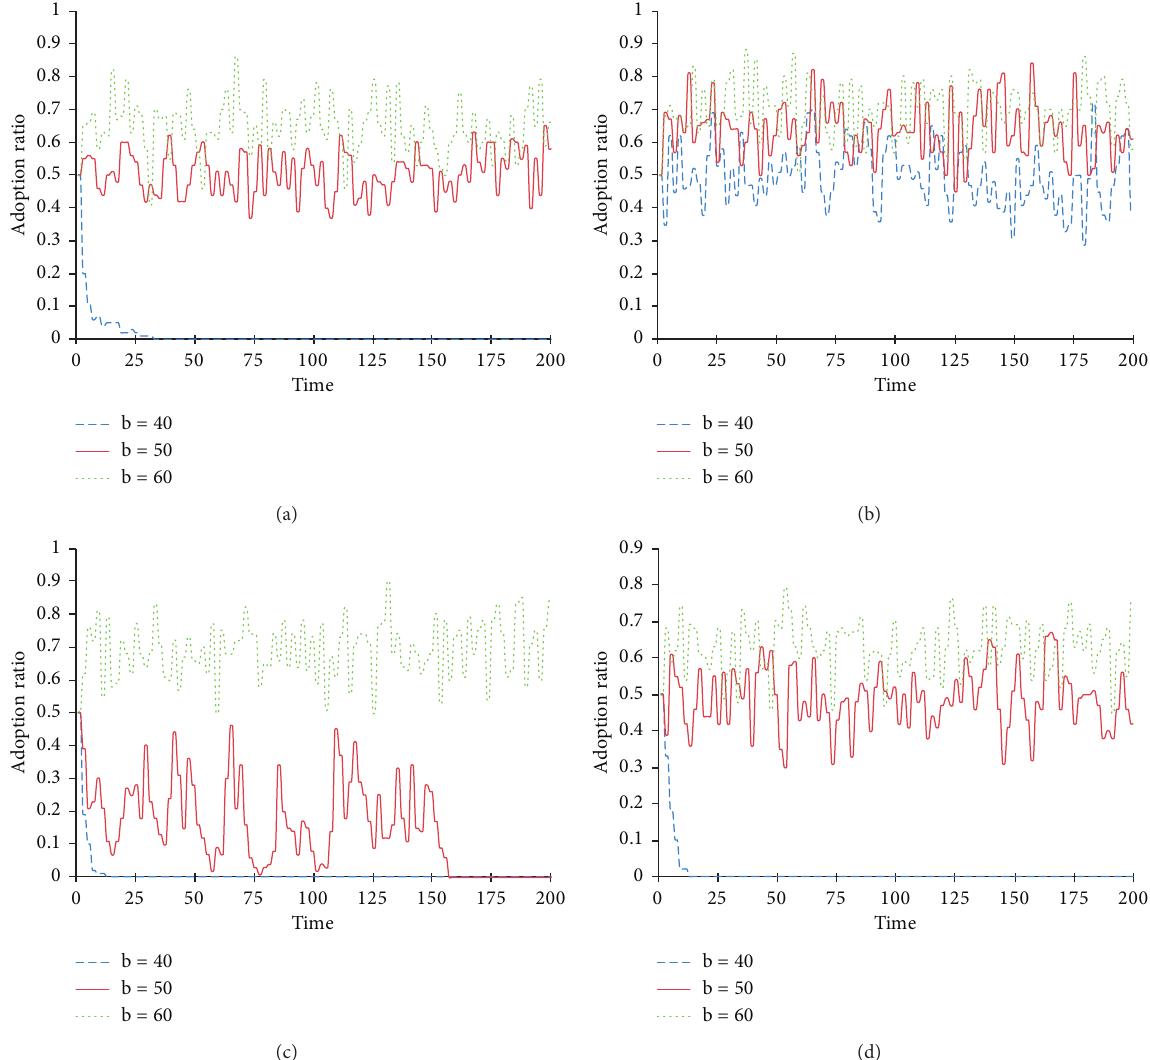
Figure 8: Impact of adoption benefit on product diffusion. (a) No overconfidence model. (b) Benefit and cost overconfidence model. (c) Benefit overconfidence model. (d) Cost overconfidence model.